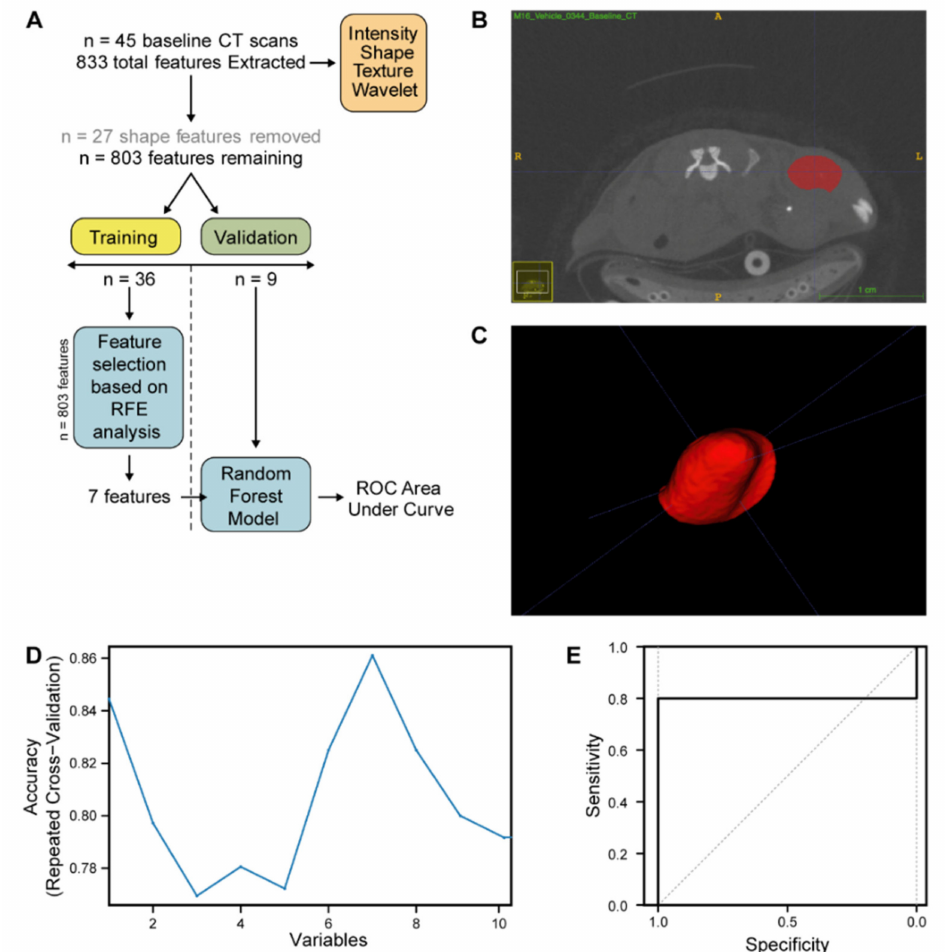
Figure 5. Radiomic analysis of pre-treatment CT images of CRC0076 and CRC0344 can successfully distinguish between the PDXs using seven unique radiographic features. ( A ) Visual Representation of PDX radiomic analysis workflow. n = 45 baseline CT scans were partitioned into a training dataset ( n = 36) and validation dataset ( n = 9) before Recursive Feature Elimination was performed on the training dataset. ( B ) Representative CT axial slice of a mouse implanted with CRC PDX CRC0344. Region of interest (ROI, in red) was drawn semi-automatically on every slice containing tumour to enable segmentations of the tumour for radiomic feature extraction. ( C ) 3D representation of the mask used to segment the tumour. ( D ) Output of the recursive feature elimination (RFE) method. Using an RFE algorithm the ideal number of features was identified as 7 for radiomic model construction. ( E ): Graph depicting the result of the receiver operating characteristic (ROC) area under the curve (AUC) analysis of the 7 features identified by the model in a test cohort ( n = 9). AUC is 0.8 (95% Confidence interval